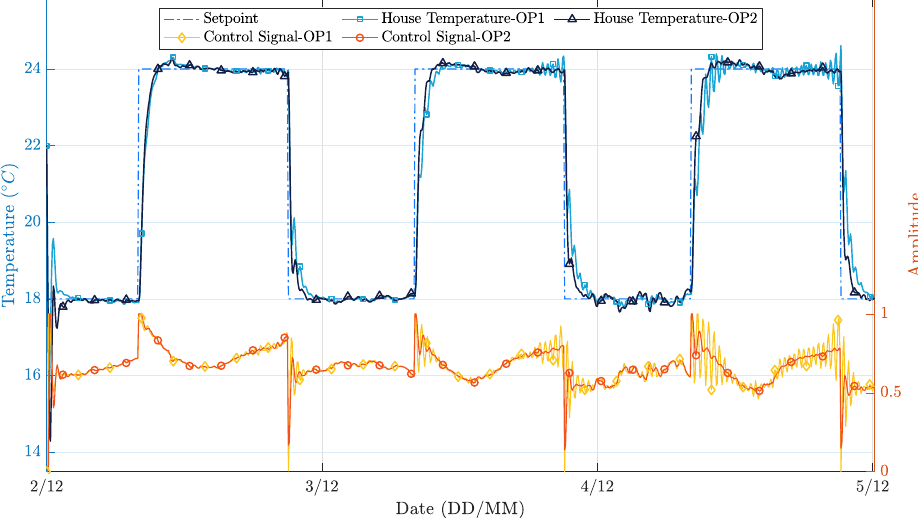
Figure 8. House temperature variation during the simulation time for two different implementations of the PP controller.